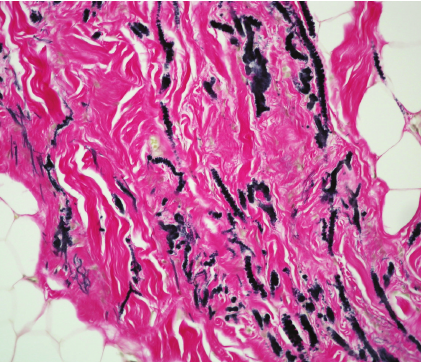
Figure 5: Weigert’s elastin stain showing deeply staining branched and unbranched elastin fibres, between benign fibroblasts and adi- pose